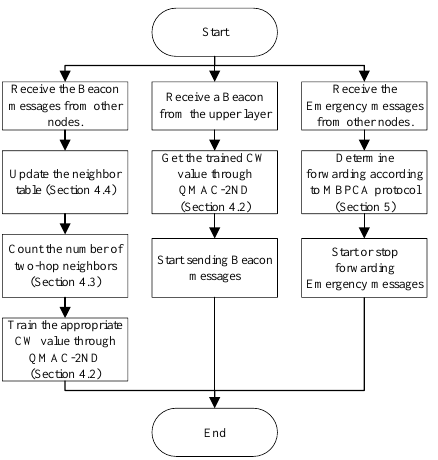
Figure 2. The system flow of the work proposed in the paper.